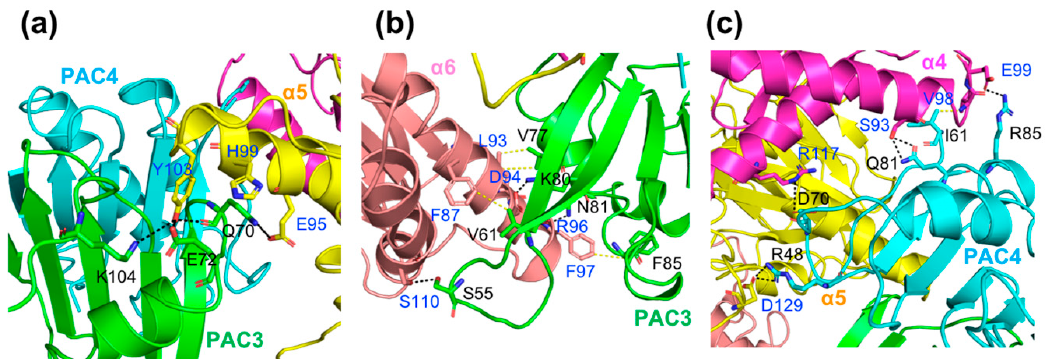
Figure 4. Predicted interaction interfaces between the PAC3-PAC4 heterodimer and proteasomal α 4- α 5- α 6 subunits. ( a ) PAC3- α 5. ( b ) PAC3- α 6. ( c ) PAC4- α 4 or α 5 interfaces. Residues involved in the interactions are shown as stick representations. Potential hydrogen bonds and non-polar interactions are indicated as black and yellow dotted lines, respectively.